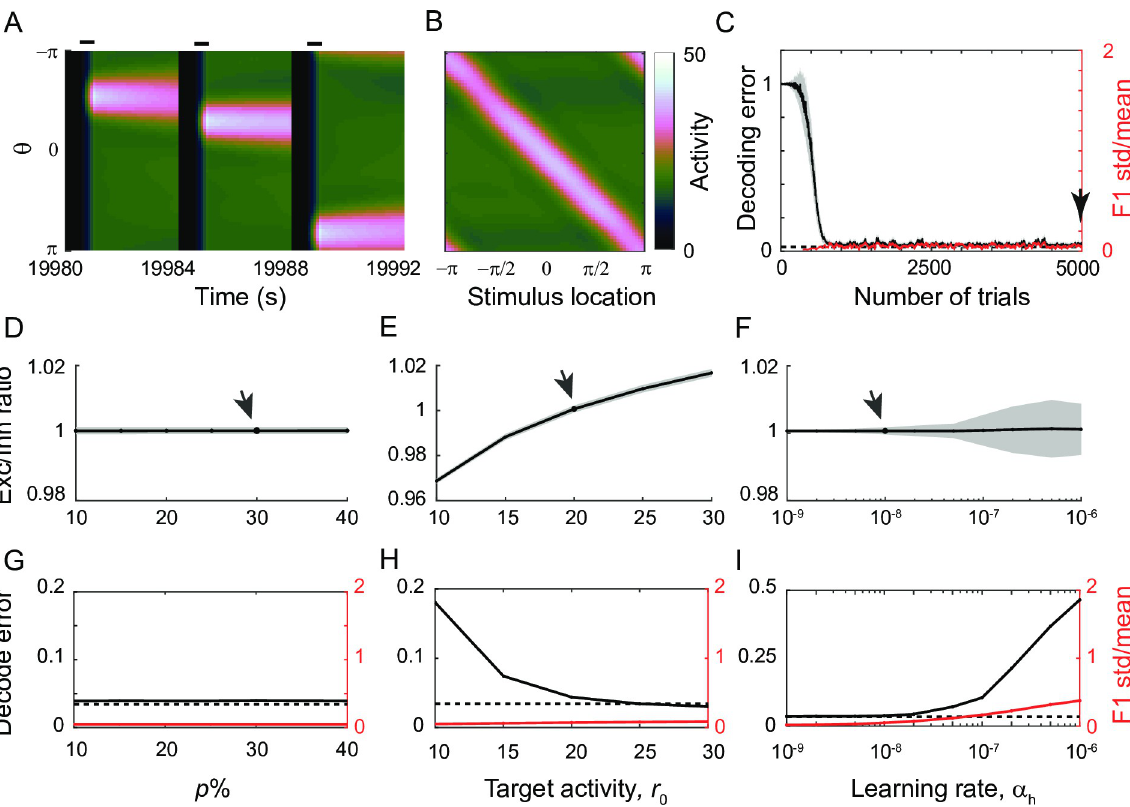
Fig 8. The effect of homeostatic plasticity under global perturbation. A: Recovery of location-coded memory under homeostatic plasticity with target rate r = 20, learning rate α = 10 − 8 and perturbation strength p = 30% in the E-to-E connections (arrow in D-F). B: Activity pattern 0 h at the end of the delay period after the recovery (arrow in C). C: Decrease of decoding error (black) and preservation of translation-invariance (red) with learning. D-F: Dependence of postsynaptic E-I ratio on target firing perturbation strength p (D), rate r 0 (E), and learning rate α h (F). Note that, unlike Fig 6D, the E-I ratio is not defined by eigenvalue or in the Fourier domain. As homeostatic plasticity modifies all incoming synapses of a neuron with a common factor, we quantified the E-I ratio compared to that before perturbation for each neuron. The mean is shown in black, and the standard deviation across neurons is shown in grey shaded area. G-I: Decoding error and normalized deviation of spatial selectivity for various p (G), r 0 , (H), α h